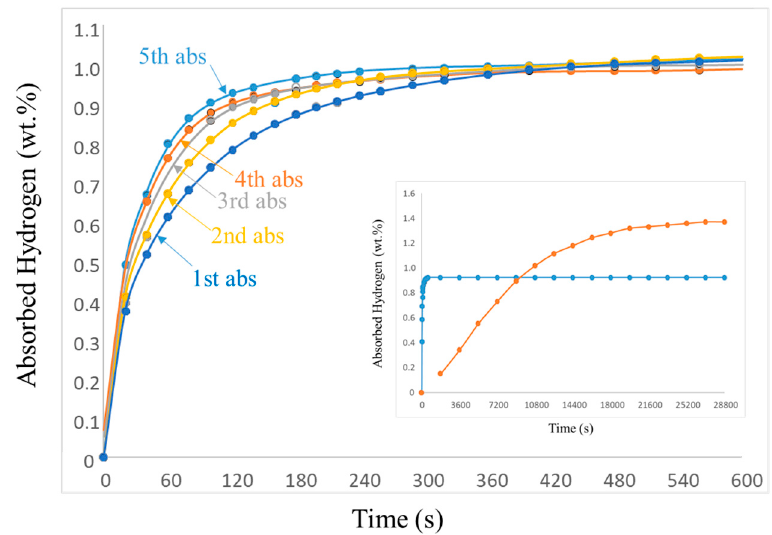
Figure 8. First hydrogenation (activation, in the inset) and cycling measurement of TiFe + 12 wt.% of Hf. Measurements were done at room temperature and under 20 bars of H 2 .